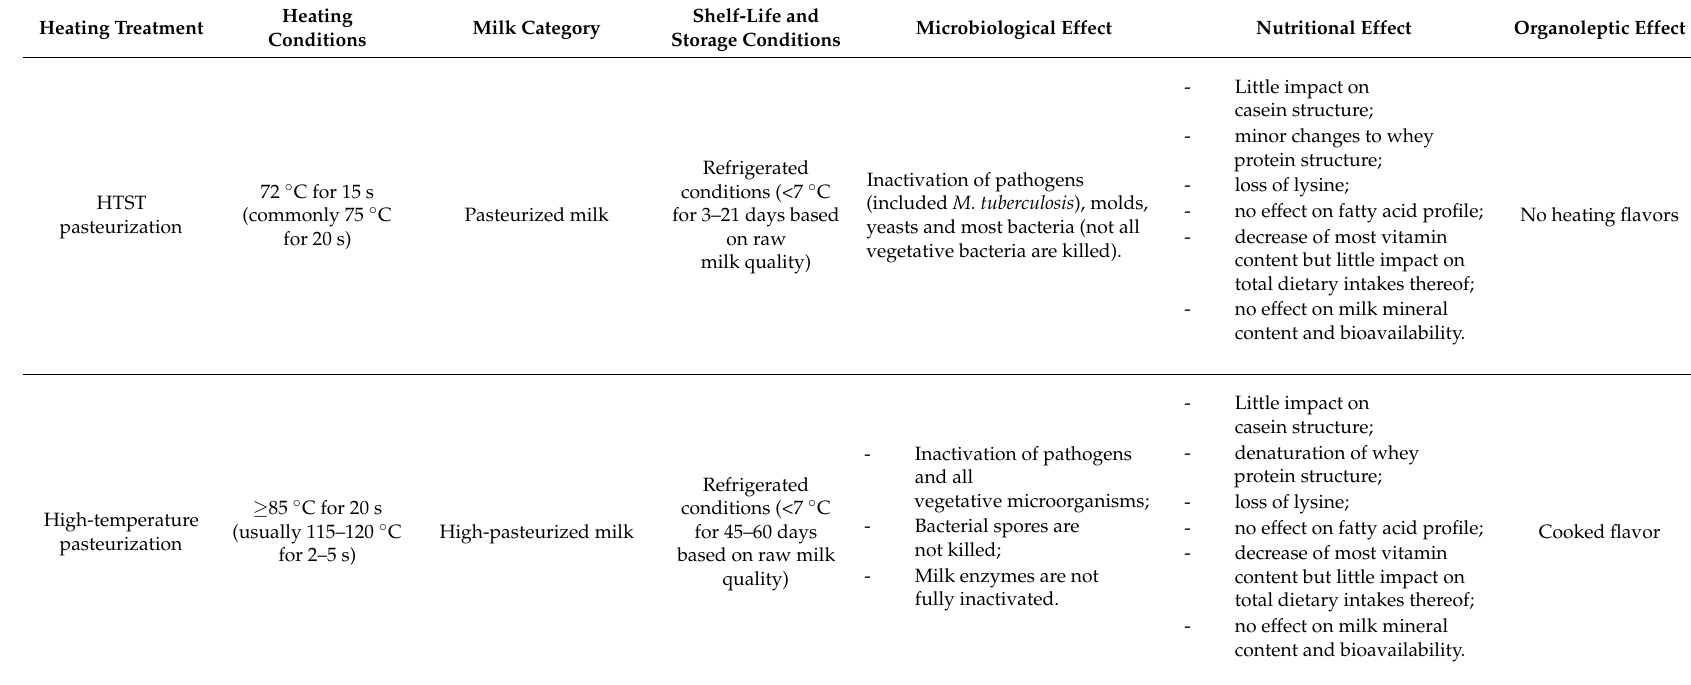
Table 4. Milk heat-treatments and effects on microbiological, organoleptic and nutritional